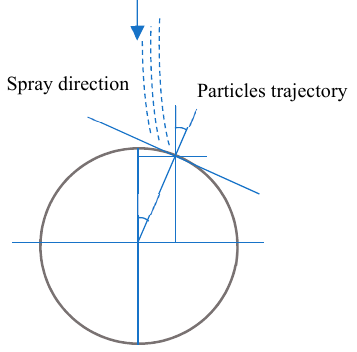
Figure 23. Schematic curved substrate and particles possible trajectory before impact.